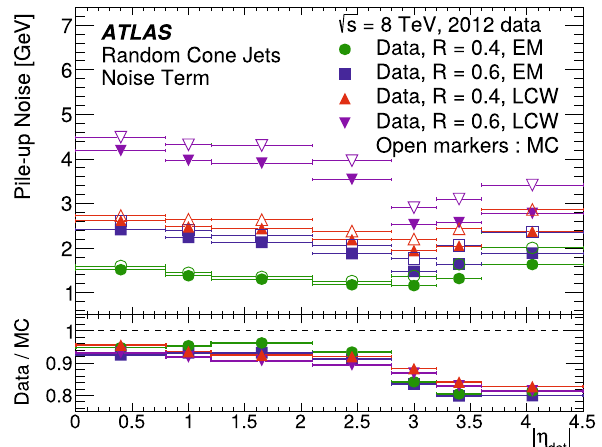
Fig. 52 Themagnitudeoftheexpectedfluctuationswithindifferentjet radii at the constituent scale as a function of | η | for data (filled markers) and MC simulations (open markers). The results are shown for R = 0 .